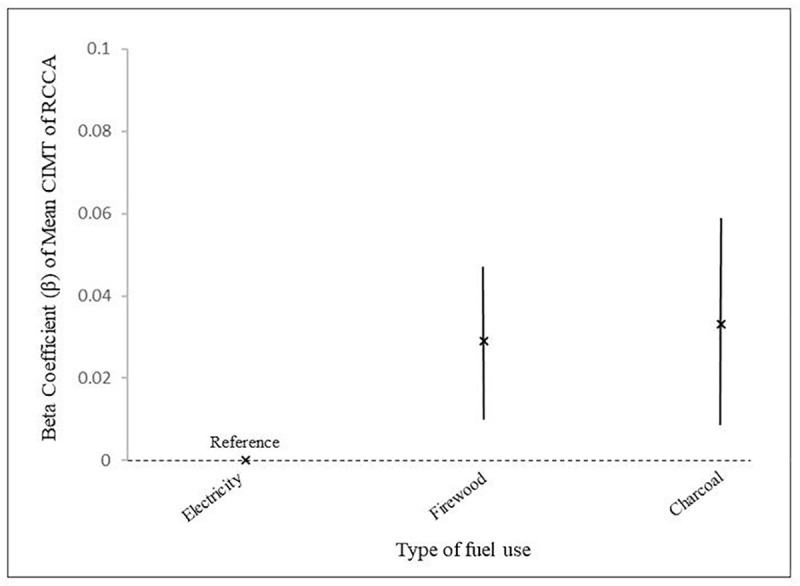
Beta coefficient of mean CIMT of the RCCA by type of fuels use.